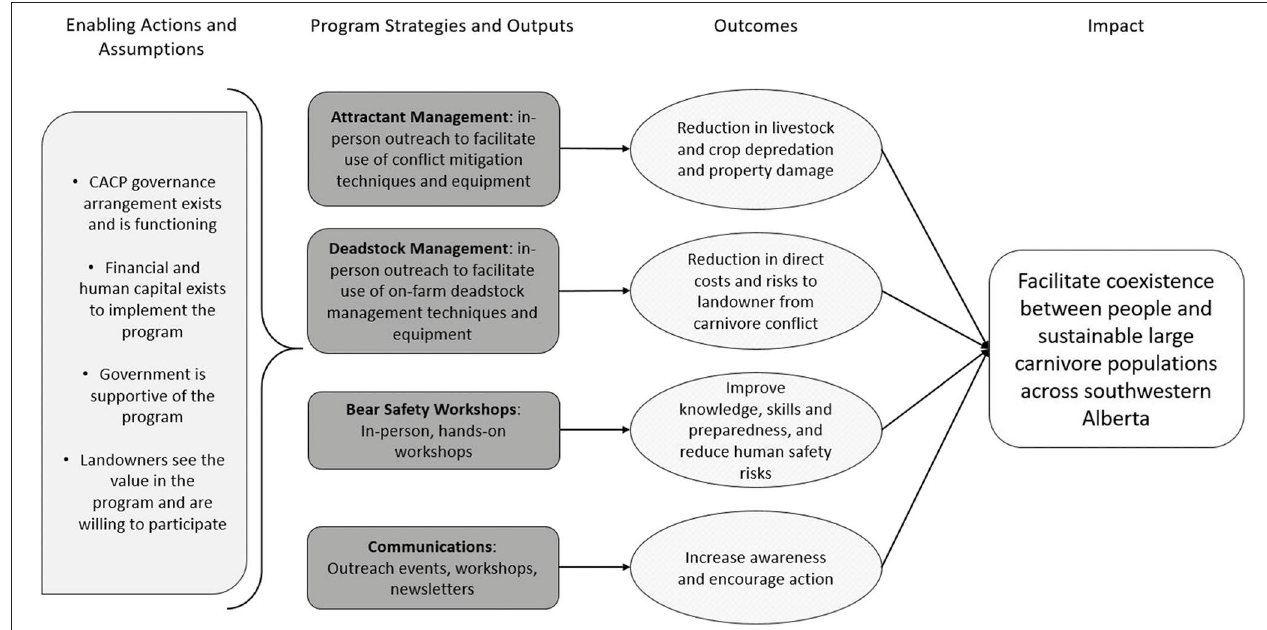
FIGURE 1 | Carnivores and Communities Program simplified theory of change, following methods adapted from Biggs et al.